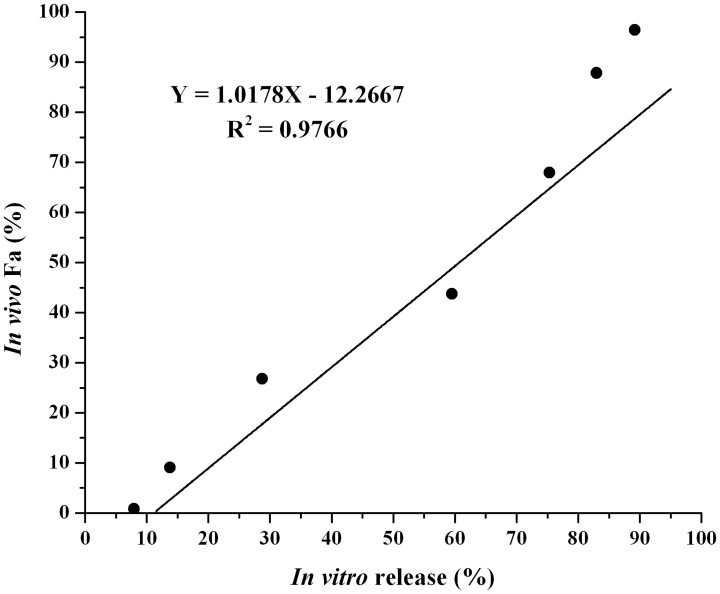
Linear regression plot for the percent released in vitro versus percent absorbed in vivo.